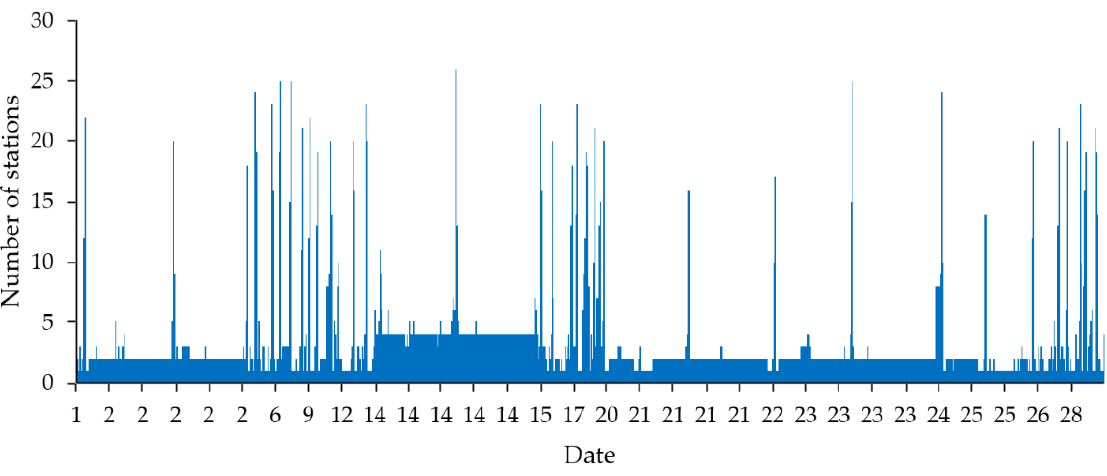
Figure 9. Plot of the distribution of simultaneously occurred discrepancies in July 2017. Table 4 is a sample of the lists of simultaneous sequentially repeated disturbances.